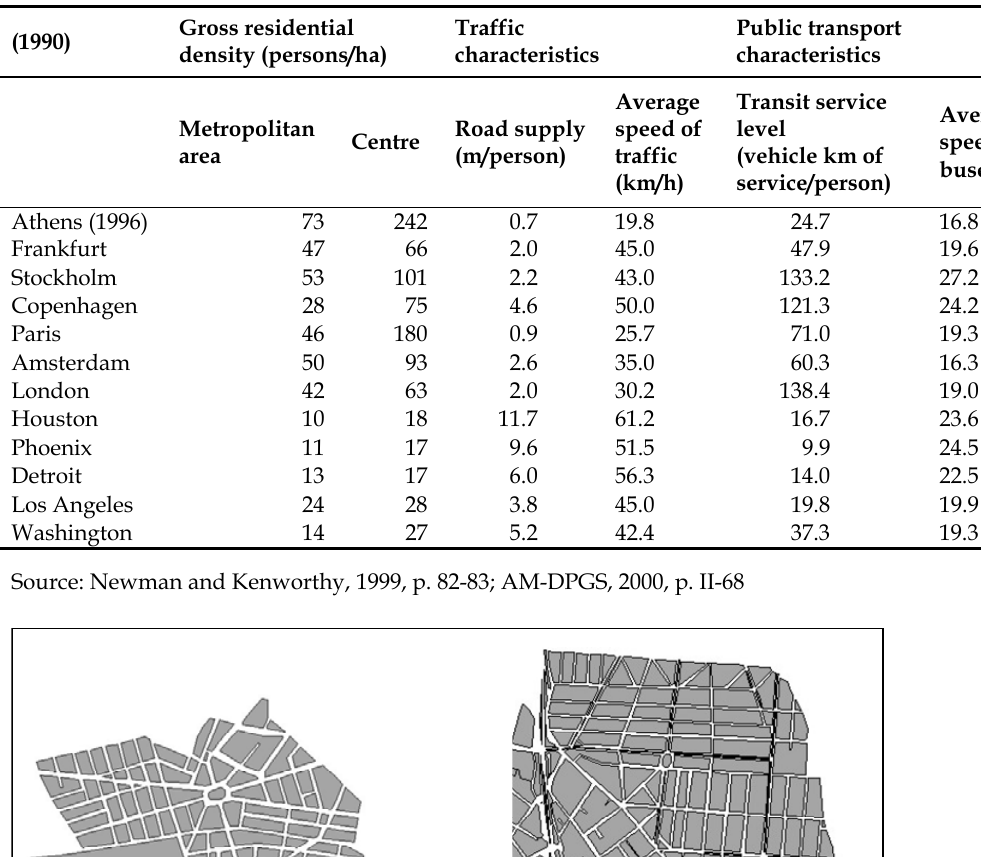
Table 1. Residential densities and transportation system characteristics in Athens and other